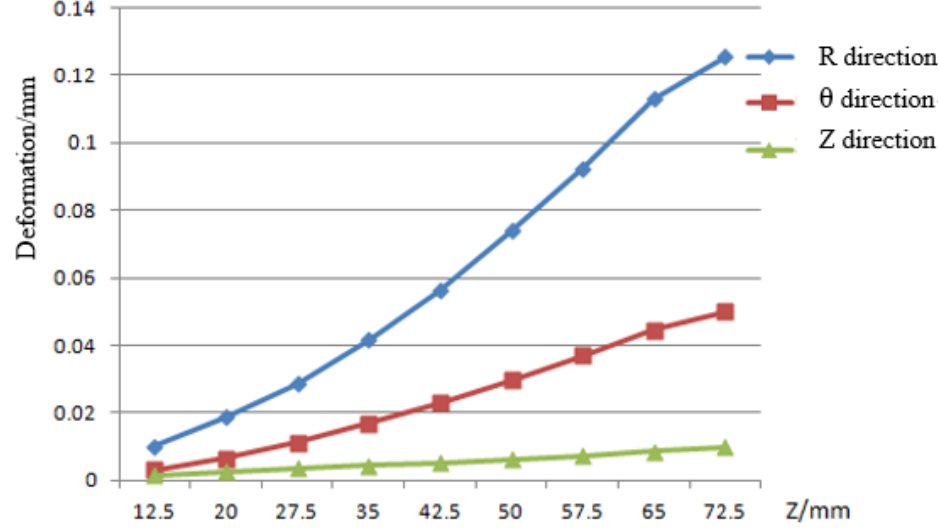
Figure 5. Deformation in three directions with the position change of the milling in Z direction.